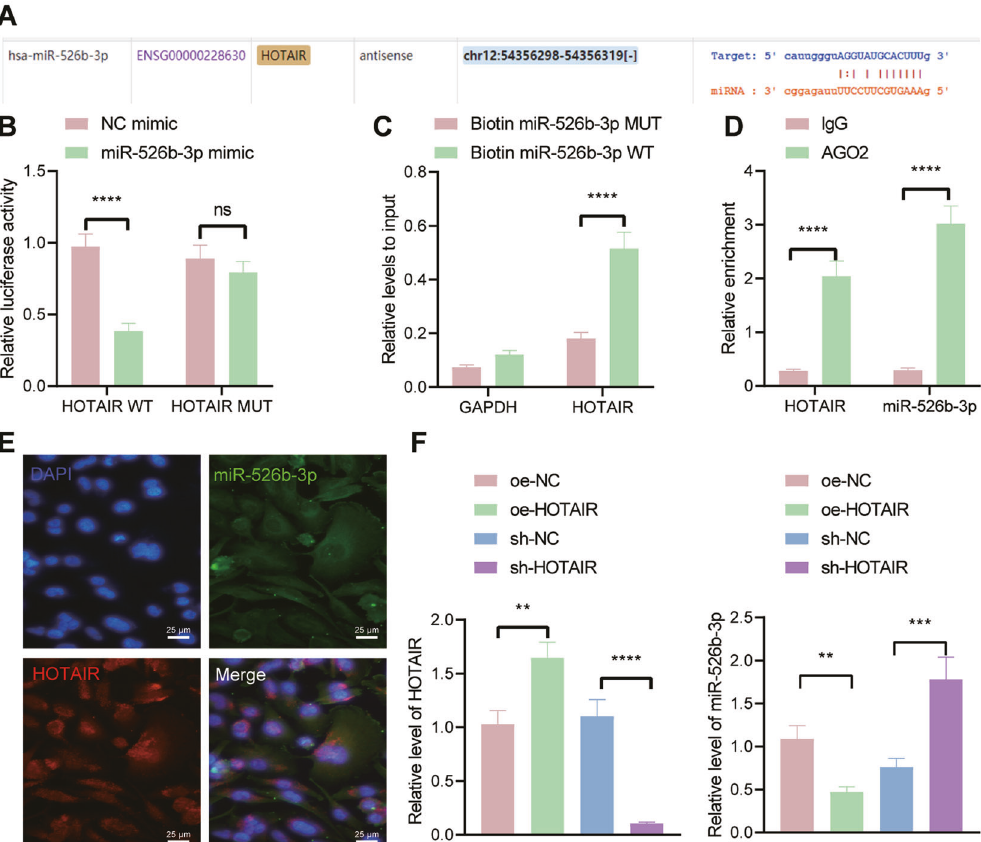
Fig. 3 HOTAIR competitively binds to miR-526b-3p in U251 cells. A The predicted binding sites between HOTAIR and miR-526b-3p by the starBase database. B Binding between miR-526b-3p and HOTAIR con fi rmed by dual-luciferase reporter assay. C Enrichment of HOTAIR in U251 cells transfected with Bio-miR-526b-3p-WT or Bio-miR-526b-3p-MUT assessed by RNA pull-down assay. D Binding between HOTAIR and miR-526b-3p analyzed by RIP assay. E FISH analysis of subcellular localization of HOTAIR and miR-526b-3p in U251 cells. F RT-qPCR detection of miR-526b-3p expression in U251 cells treated oe-HOTAIR or sh-HOTAIR. ** p < 0.01, *** p < 0.001 or **** p < 0.0001. ns indicates no signi fi cant difference between the two groups. Each experiment was repeated three times